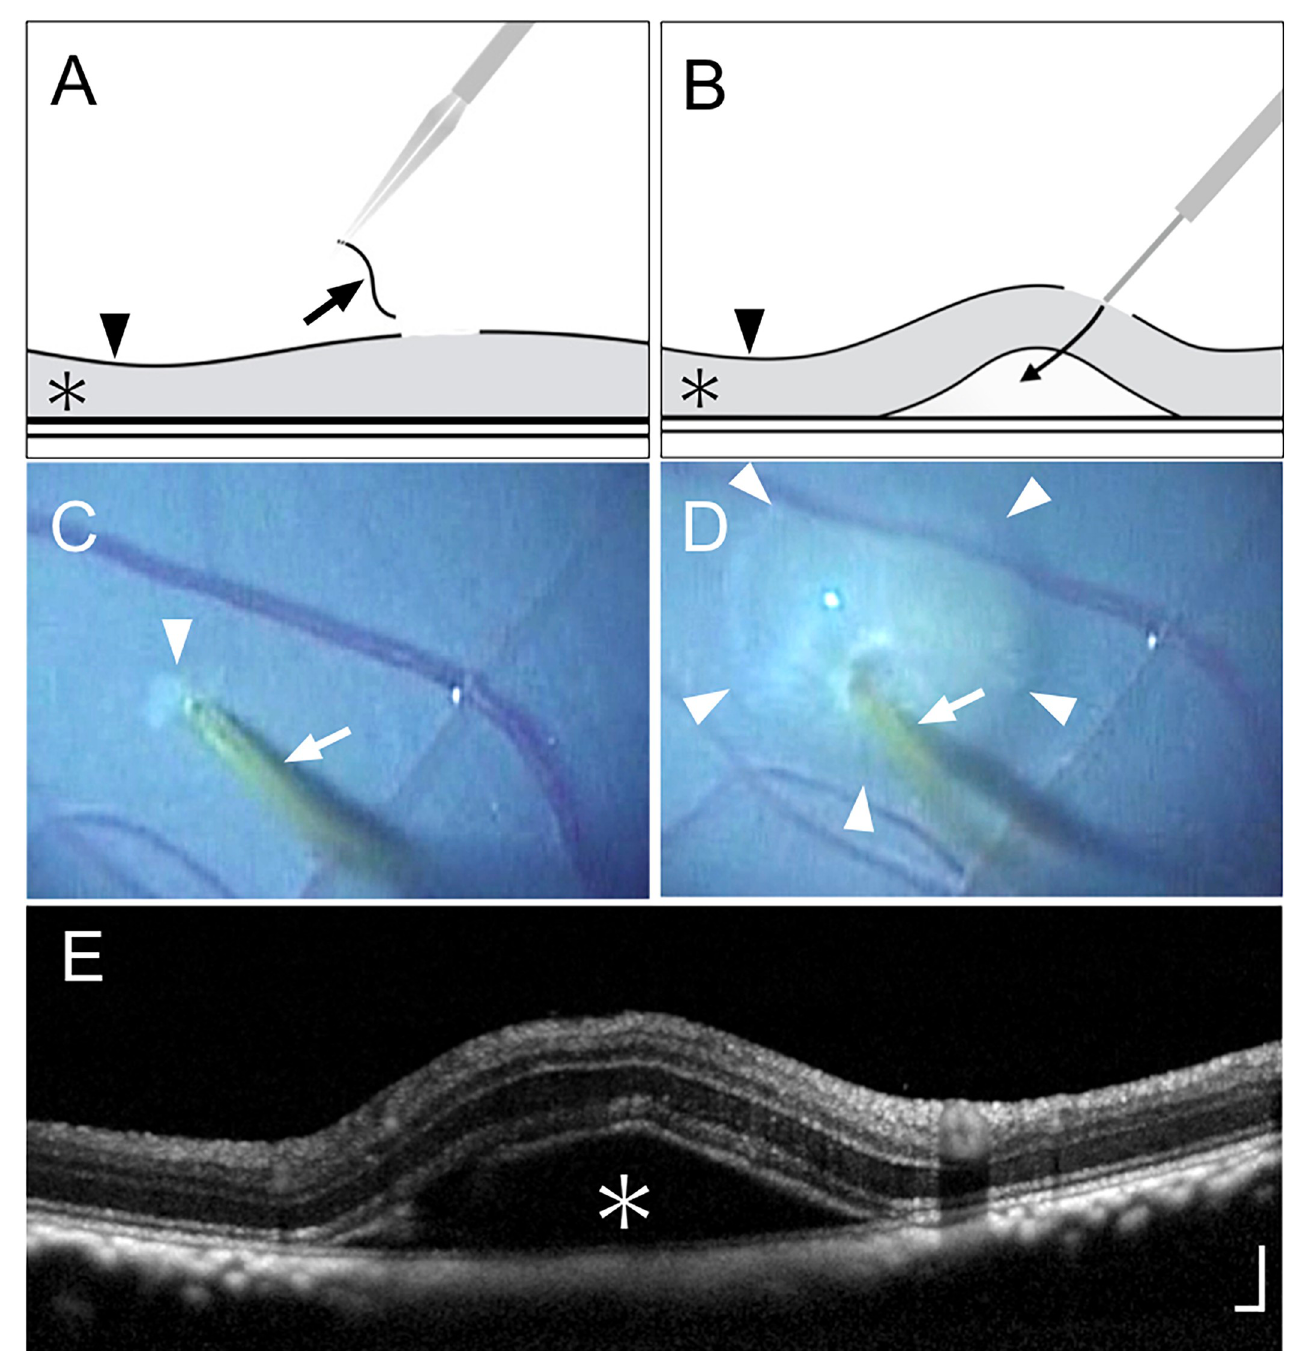
Fig 1. Local removal of internal limiting membrane and subretinal injection of balanced salt solution. (A) Schematic drawing of local internal limiting membrane (ILM) removal showing the removed ILM (arrow), retina (asterisk), and intact ILM (arrowhead). (B) Schematic drawing of the subretinal injection procedure. Balanced salt solution (BSS) was injected with a 38-gauge cannula by placing the cannula tip in contact with the retinal nerve fiber layer. The arrow indicates the flow of the injected BSS; the asterisk and arrowhead indicate the retina and ILM, respectively. (C) Surgical photograph after local ILM removal. The arrow indicates the 38-gauge cannula; the arrowhead indicates the area of peeled ILM. (D) Surgical photograph during subretinal injection. The arrow indicates the 38-gauge cannula; arrowheads indicate the area of retinal detachment due to subretinal injection of BSS. (E) Optical coherence tomography 30 minutes after subretinal injection. The asterisk indicates retinal detachment caused by the procedure. Scale bar = 200 μ m.